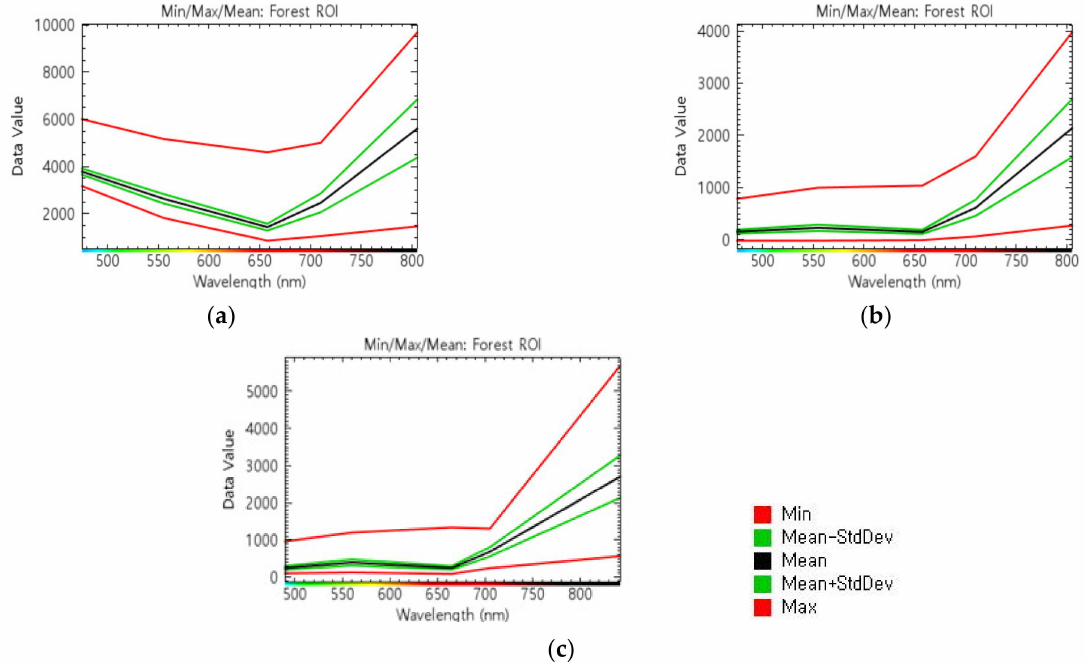
Figure 3. Comparison of the Statistics of Wavelengths for Atmospheric Correction. ( a ) RapidEye: be- fore atmospheric correction; ( b ) RapidEye: after atmospheric correction; ( c ) Sentinel-2: level 2a